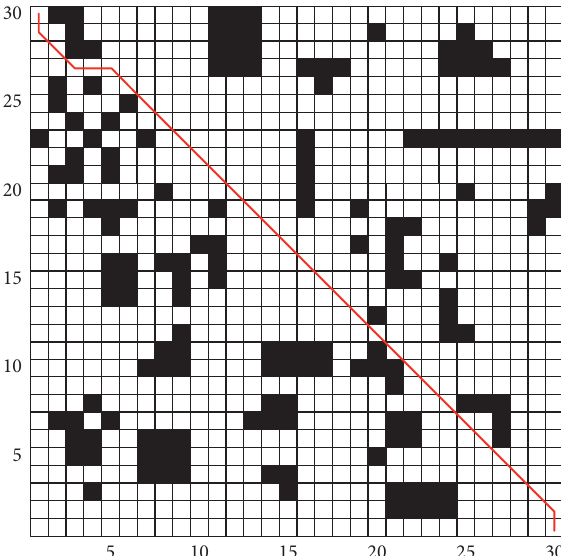
Figure 6: Improved algorithm planning path.